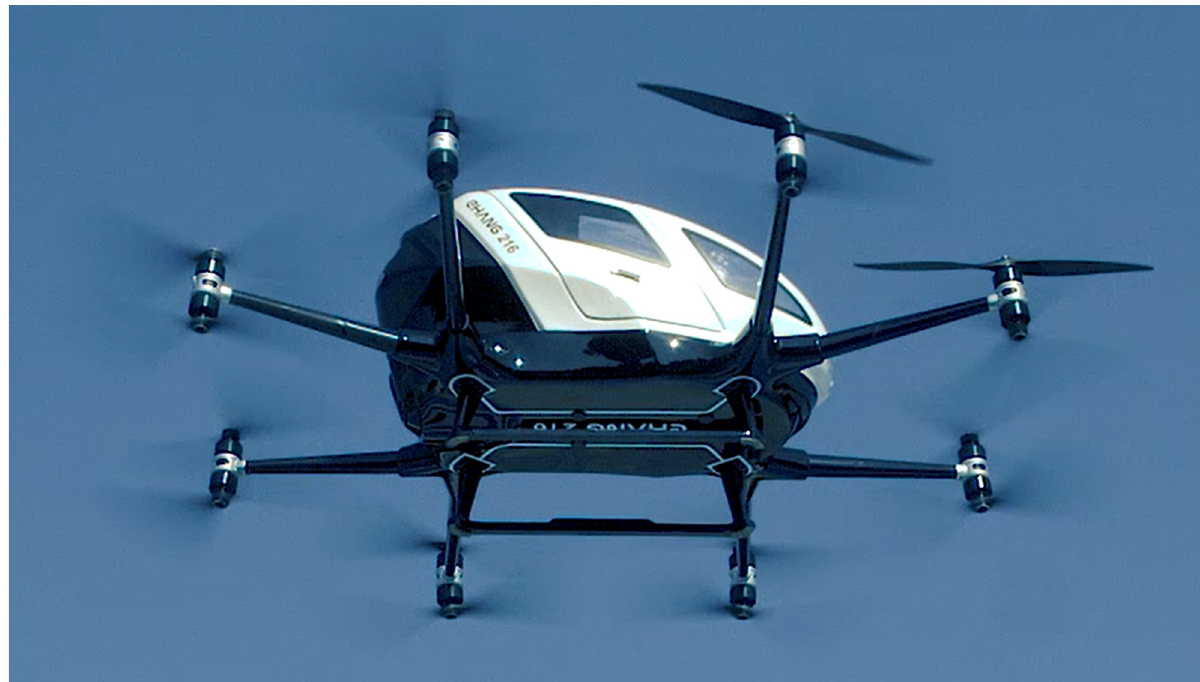
Figure 2: A real view of the EHang 216 UAM aircraft during a fl ight test ( image credit: EHang Holdings Limited, used with permission ) .